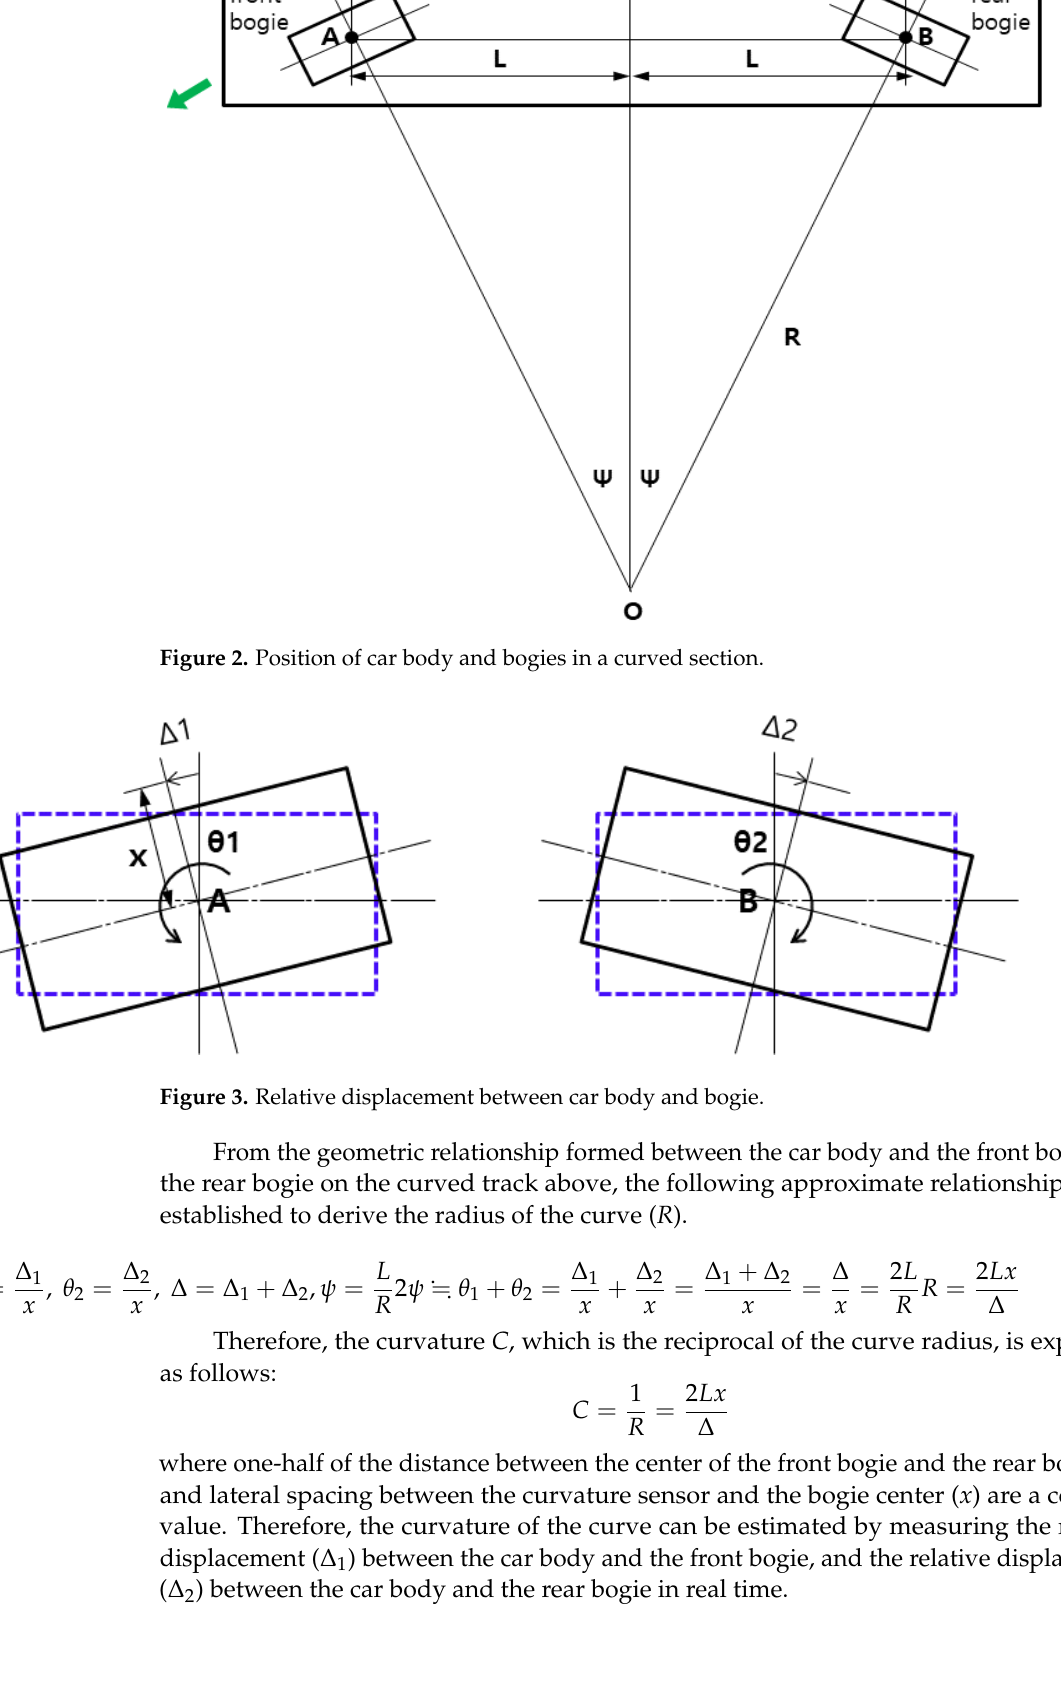
Figure 1. Position of car body and bogies in a straight line.